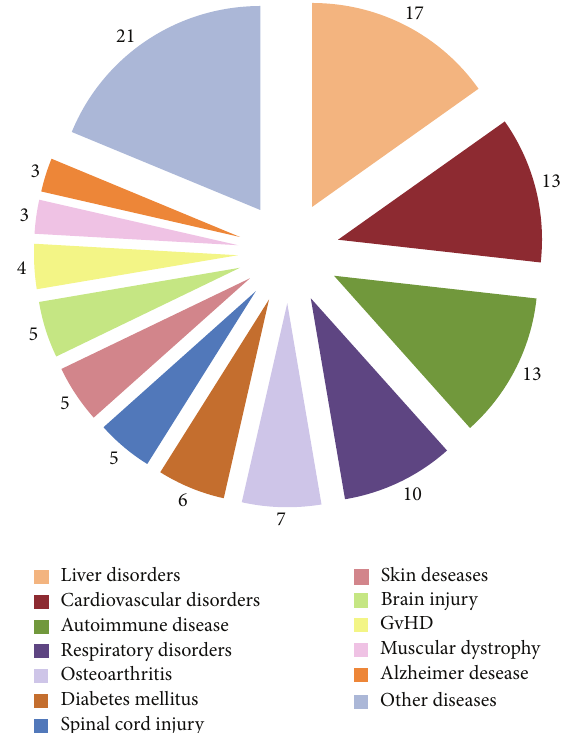
Figure 3: Number of clinical trials for UC-MSCs based therapy